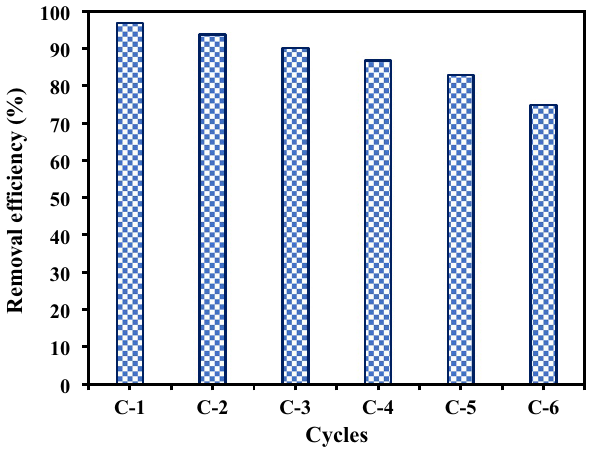
Figure 12. Reusability performance of NZVI-Si at NZVI-Si dose of 0.1 g/100 mL, initial Cr(VI) concentration of 25 mg/L, contact time of 120 min, and temperature of 20 °C.